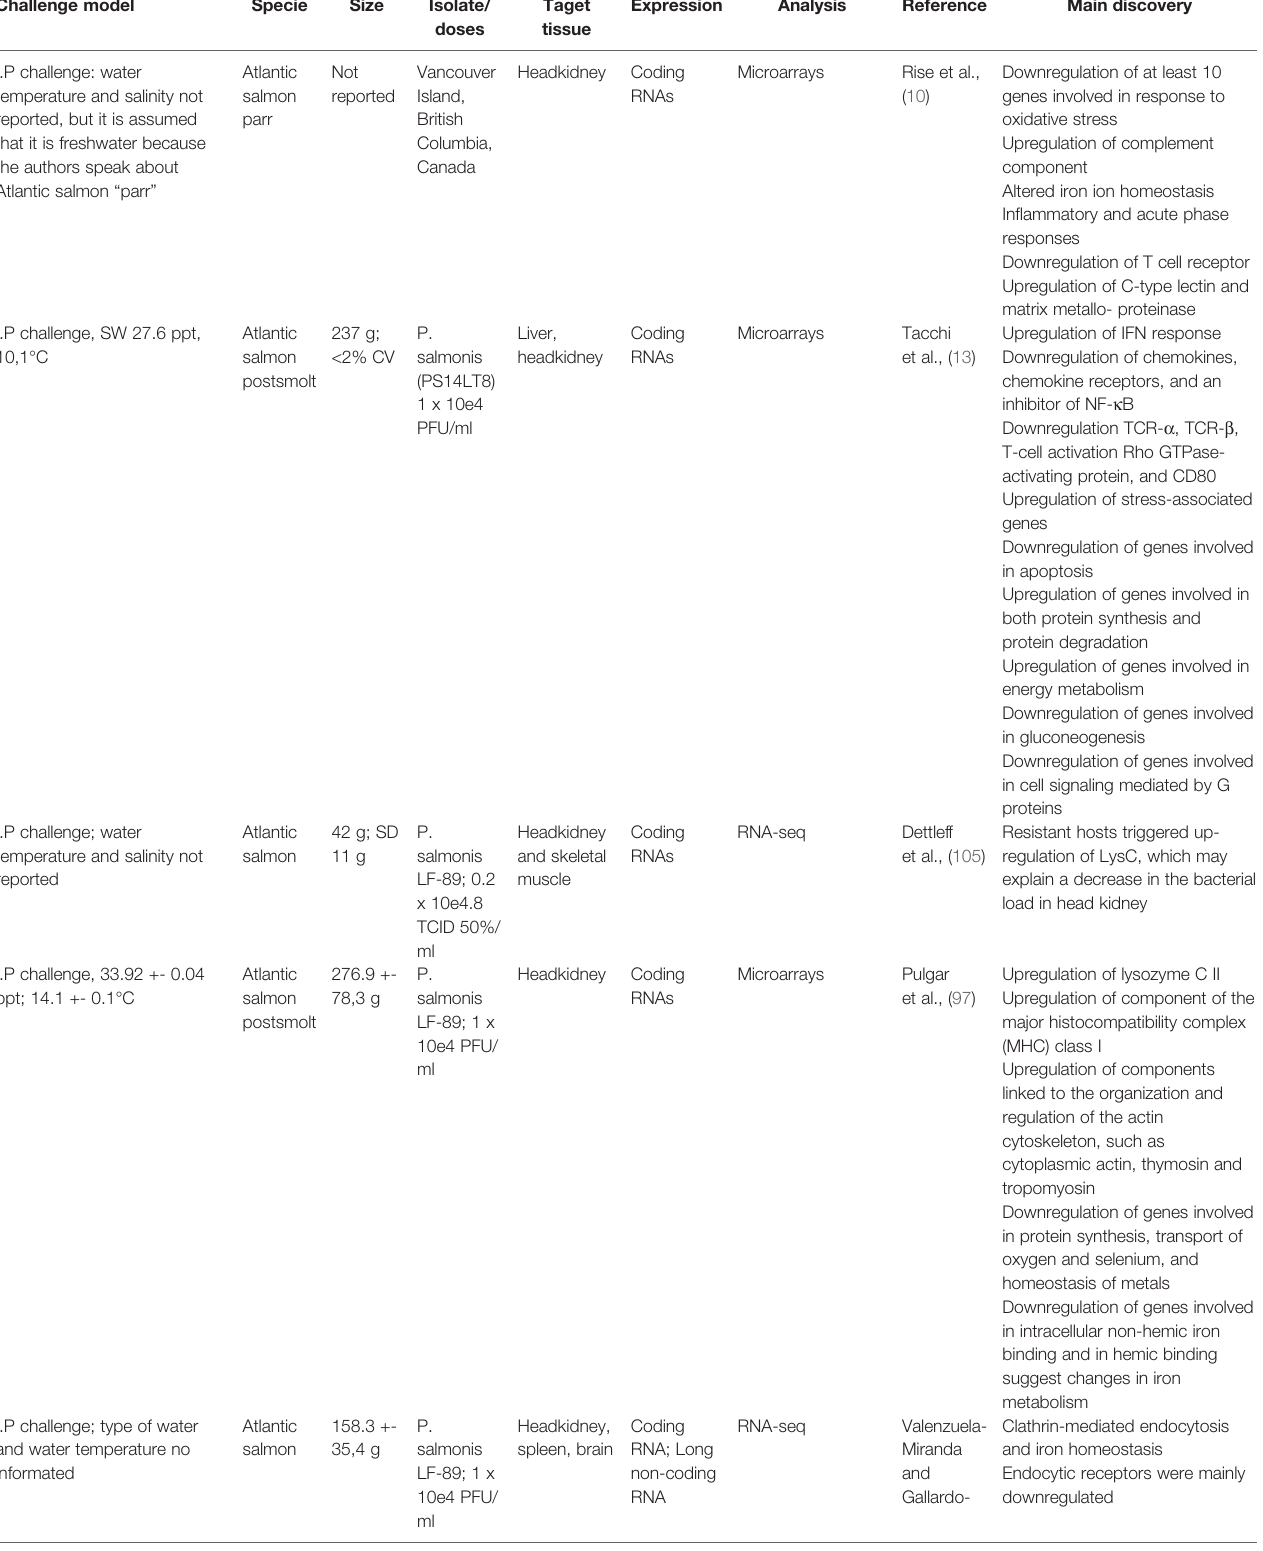
TABLE 4 | In vivo transcriptomic studies describing innate and adaptive immune responses in Atlantic salmon and Coho salmon infected with P. salmonis